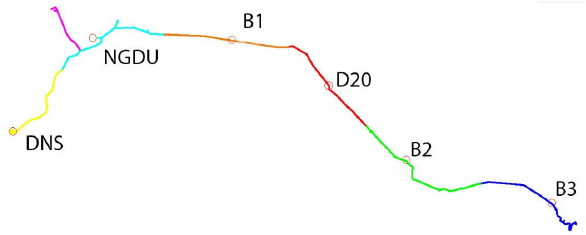
Figure 1 . Segments of the Talakan – Vitim